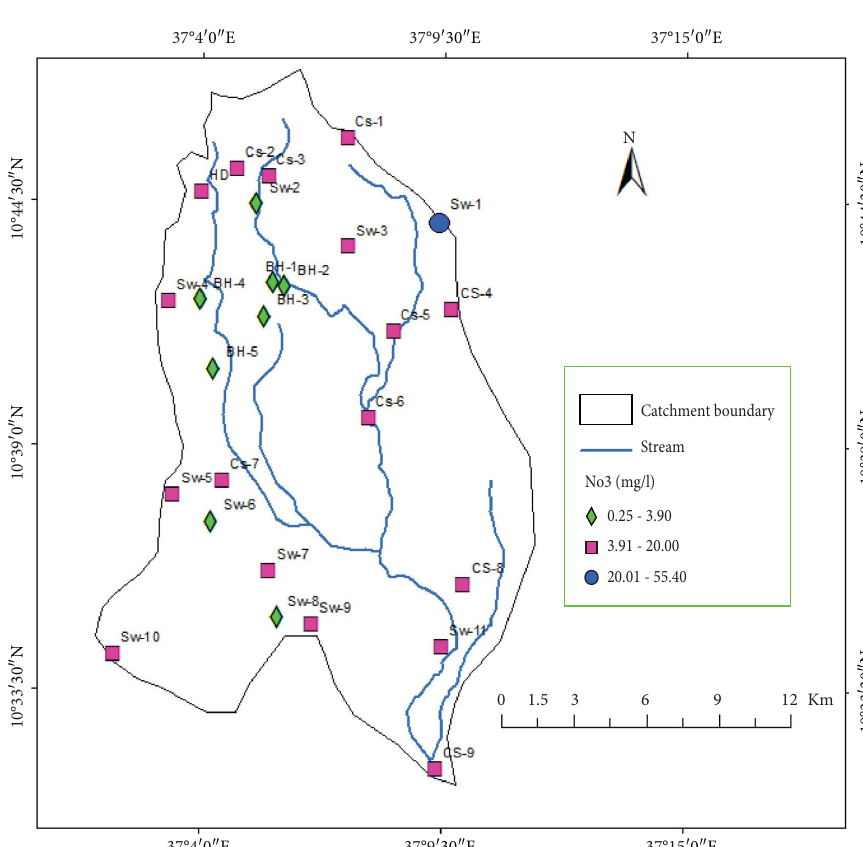
Figure 15: Spatial variability map of